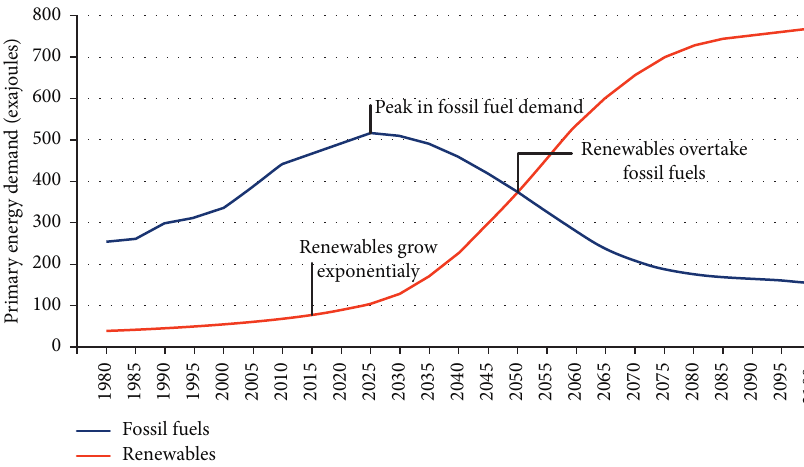
Figure 4: Forecasting of the energy transformation projects [6].